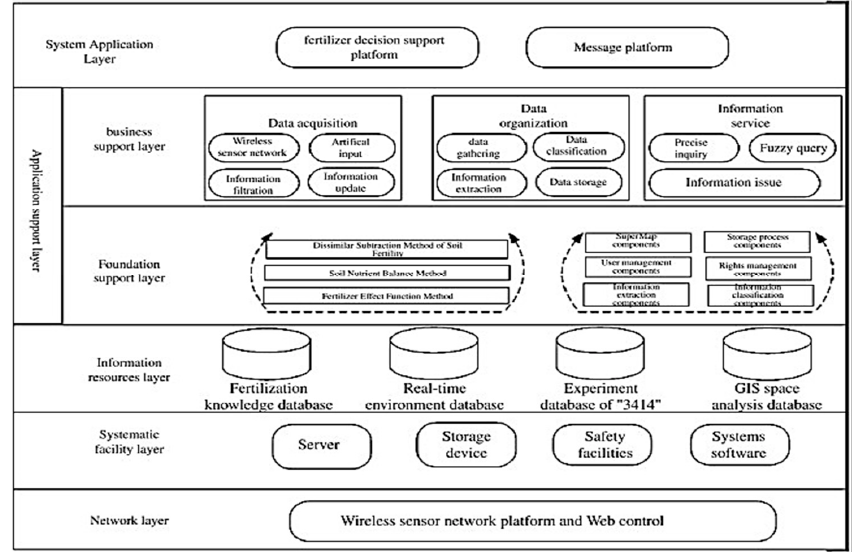
Figure 13. A structure diagram of the integrated optimal fertilization decision support system [31].